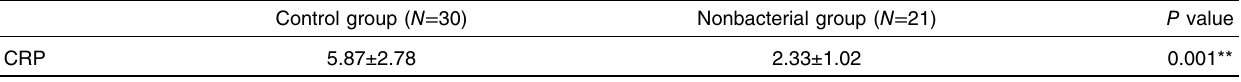
Table 18 Comparison between mean values of CRP in the control and nonbacterial groups